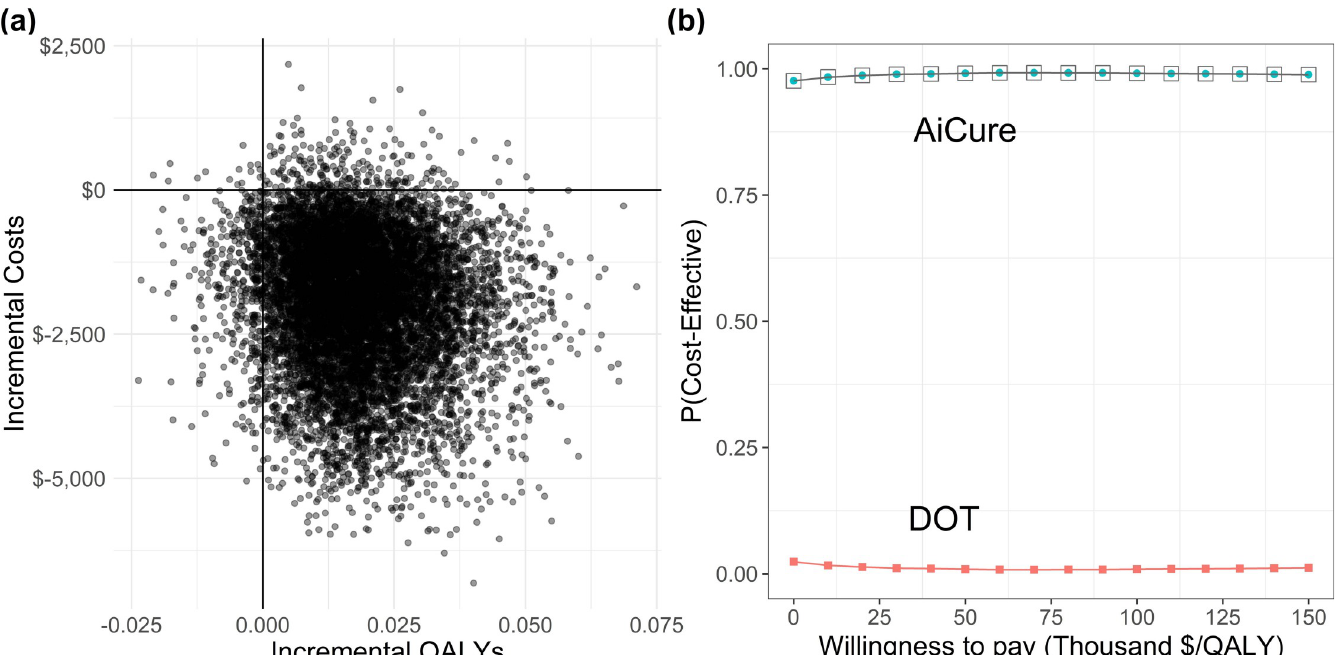
Fig 3. Probabilistic sensitivity analysis results. Panel a: Incremental values per-patient of AiCure relative to DOT. Panel b: Cost-effectiveness acceptability curve (CEAC) by treatment arm. DOT directly observed therapy, QALY quality-adjusted life year.